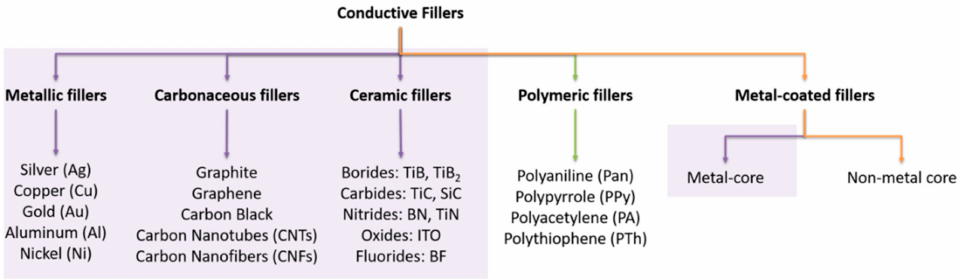
Figure 7. Classification of conductive fillers for ESD applications. Violet boxes indicate inorganic